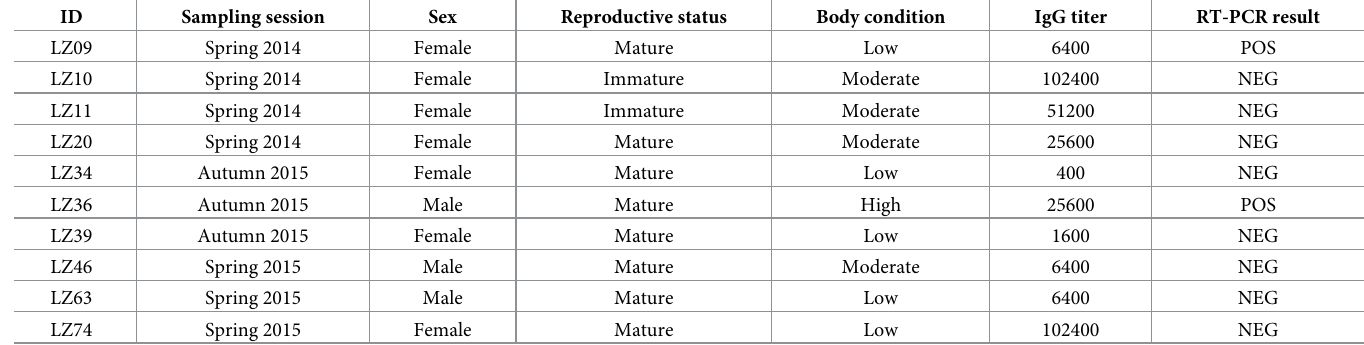
Table 4. RT-PCR result and IgG titers against Hantavirus in Scapteromys aquaticus from riverside settlements of the Parana´ flooded savanna, Santa Fe, Central Argentina, from 2014 to 2015. ID Sampling